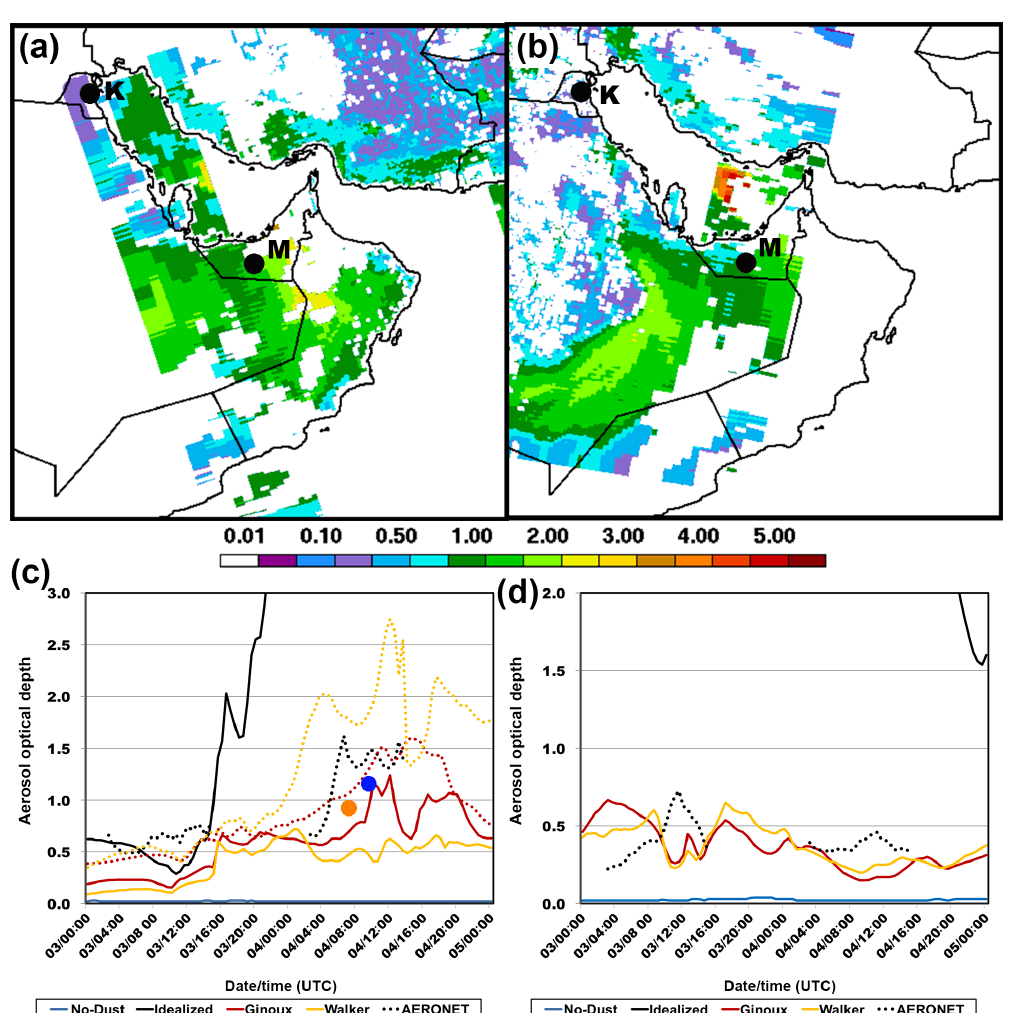
Figure 7. (a) MODIS Aqua AOD at 550nm at 09:15UTC on 4 August 2016. (b) MODIS Terra AOD at 550nm at 07:45UTC on 4 Au- gust 2016. (c, d) Time series of AERONET AOD at 500nm and modeled time series of AOD at 550nm at the locations of (c) Mezaira’a, UAE (23.11 ◦ N, 53.76 ◦ E; level 1.5 data), and (d) Kuwait University, Kuwait (29.33 ◦ N, 47.97 ◦ E; level 1.0 data). The black dots in panels (a) and (b) indicate the locations of AERONET stations at Kuwait University (K) and Mezaira’a (M). Colored, dotted lines in panel (c) correspond to the time series for an in-plume location 2 ◦ east of the Mezaira’a site, as discussed in the text. The large blue dot in panel (c) indicates the MODIS Aqua AOD, and the orange dot indicates the MODIS Terra AOD, that has been spatially interpolated to the Mezaira’a location from the retrievals in panels (a) and (b)